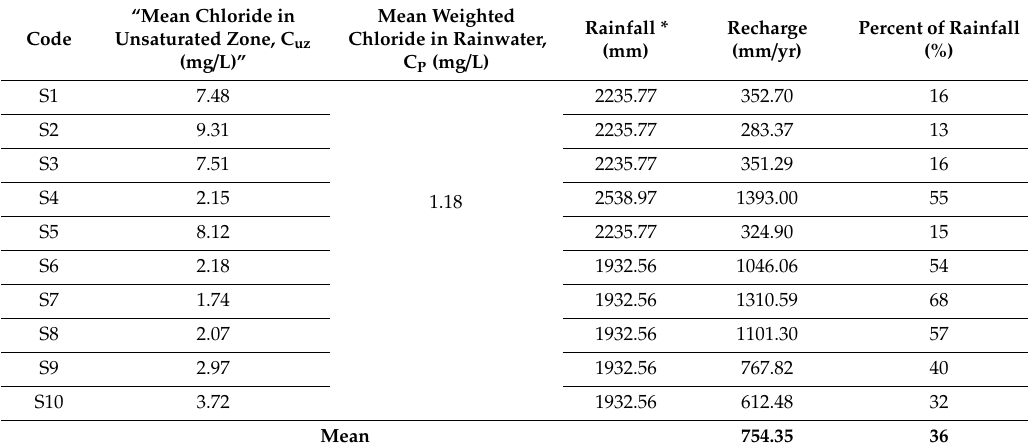
Table 2. Recharge estimated using chloride mass balance (CMB) at di ff erent